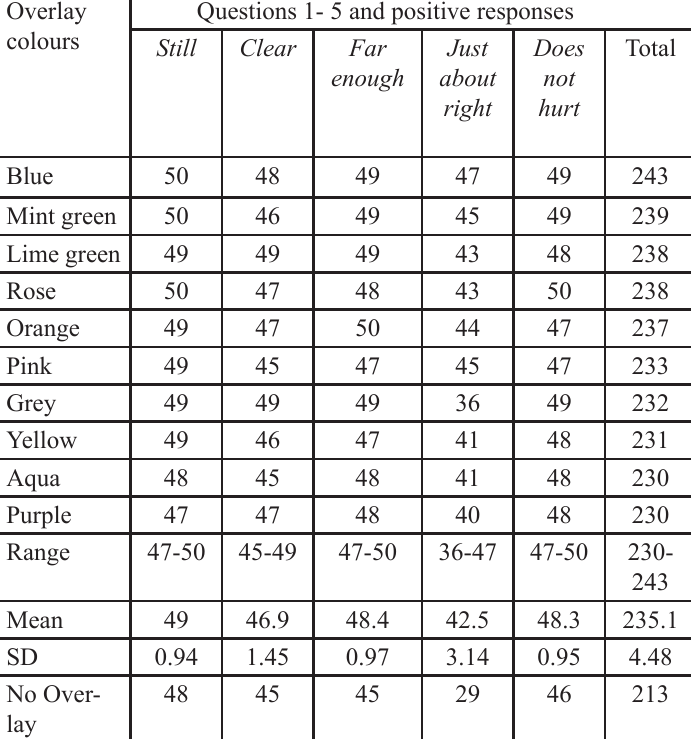
Table 1 . Showing the Wilkinson 18 questions 1-5 and the posi- tive responses with the single overlays for all subjects (N= 50). Blue overlay provided the highest number of positive responses and purple has the least. The highest score per question would be 50 and 250 for the five questions in this forced-choice pro -